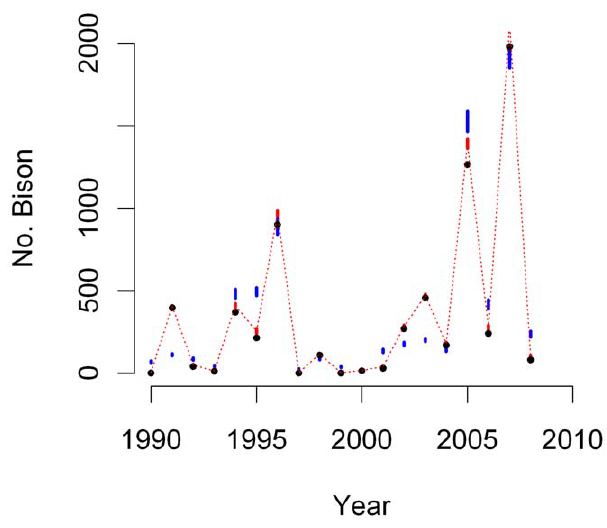
Figure 2. Modified logistic (red) predicted median (dotted lines) and 95% credible intervals (bars) of annual maxima of bison migrating beyond the northern boundary of Yellow- stone National Park during 1990–2009. Observations (black circles) were precise ( d =0.92) resulting in narrow credible intervals of the vector of true states Z N . We plotted mean process model predictions (blue bars) as p N,t ( x central + x north ) to illustrate the relative contribution of process variance and observation error.